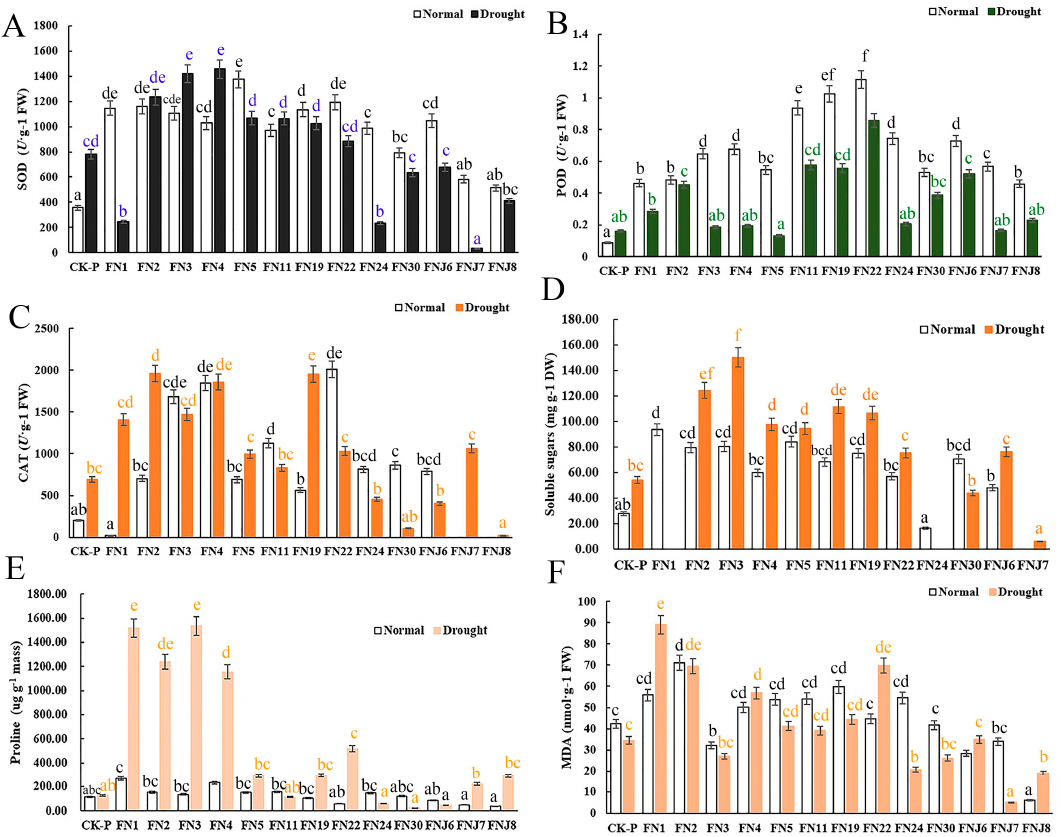
Figure 3. Differential fungal effects on rice physiological indices. ( A – F ) Respectively represent